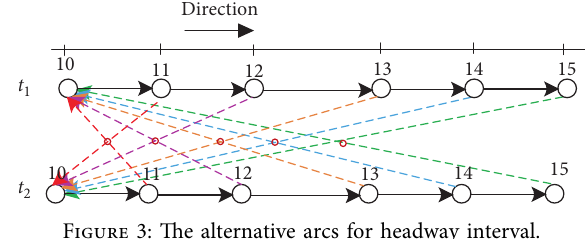
Figure 3: The alternative arcs for headway